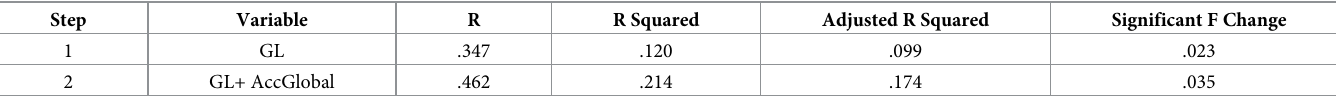
Table 3. Results of the multiple regression analysis. Step